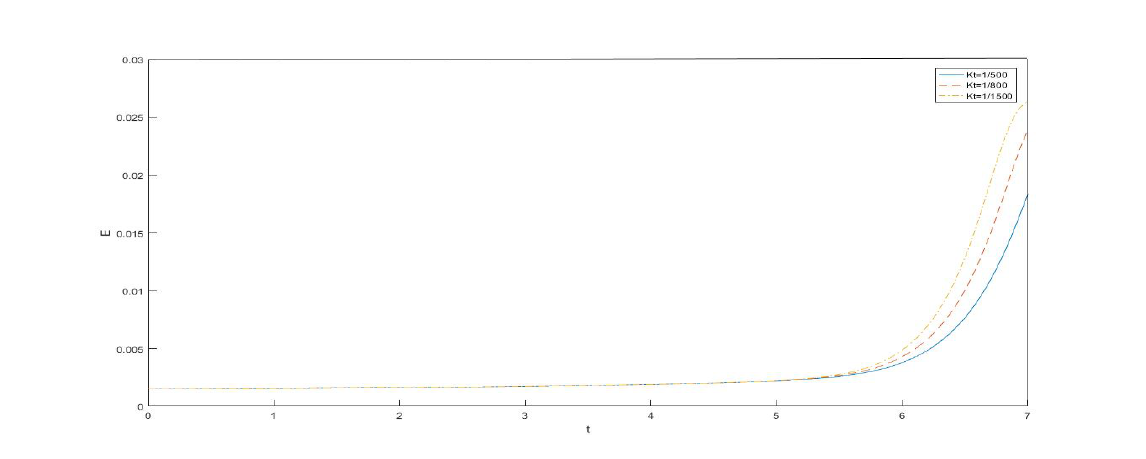
Fig. 4 Vorticity distribution for small values of α where a) at time t = 15, K T = 1 / 500, ν = 1 / 500, and m = 4, b) at time t = 15, K T = 1 / 1500, ν = 1 / 500, and m = 4.